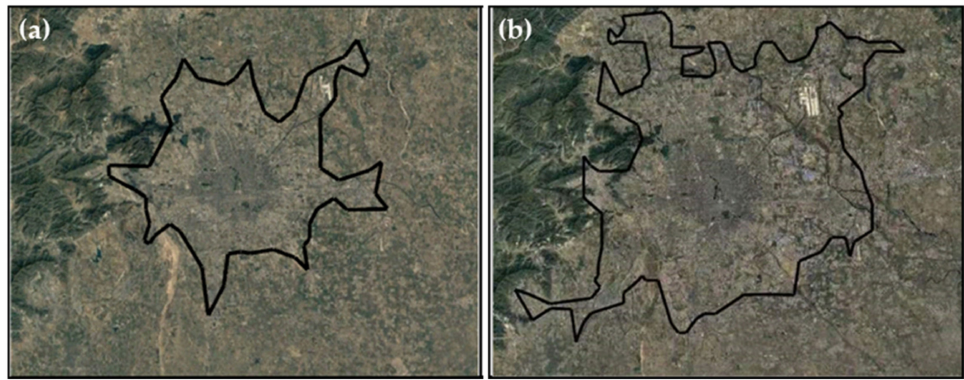
Figure 2. True color Landsat image of Beijing. ( a , b ) are images taken from Google Earth in 2001 and 2010, respectively. The polygons on the ( a , b ) are the core and extension regions,